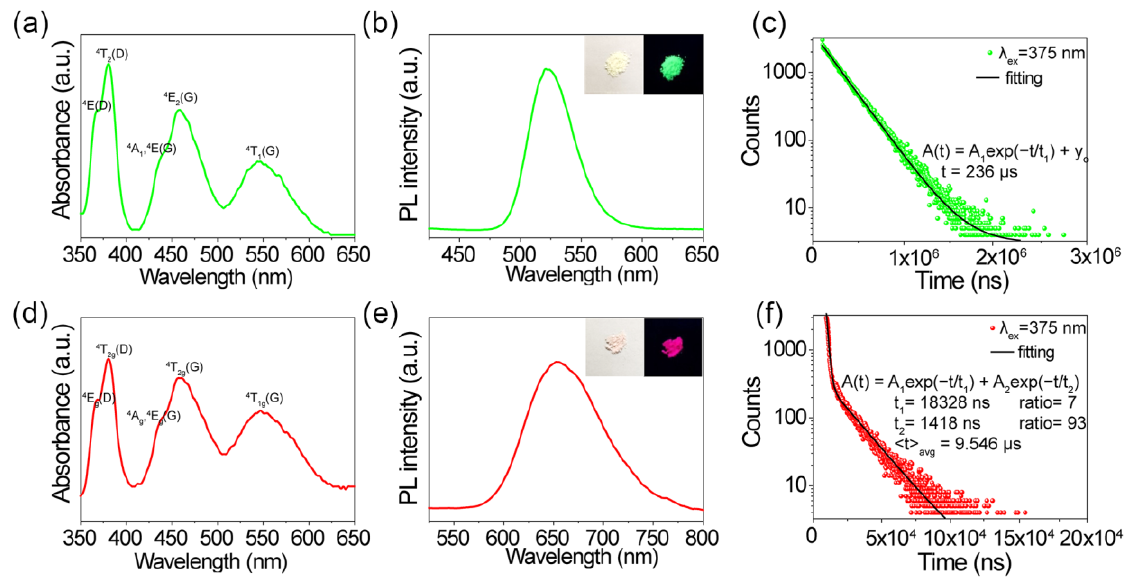
Figure 3 . Absorption and corresponding emission spectra of Cs 3 MnBr 5 ( a , b ) and CsMnBr 3 ( d , e ) at ambient conditions. Inset: photographs of Cs 3 MnBr 5 and CsMnBr 3 under room and UV light (385 nm). Time-resolved PL decays and fitting curves at 522 nm in Cs 3 MnBr 5 ( c ) and 655 nm in CsMnBr 3 ( f ), and the excitation wavelength was 375 nm.